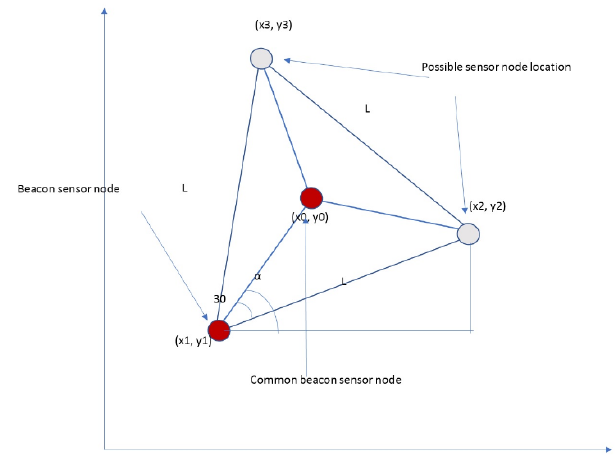
Figure 2. Primary two beacons-based